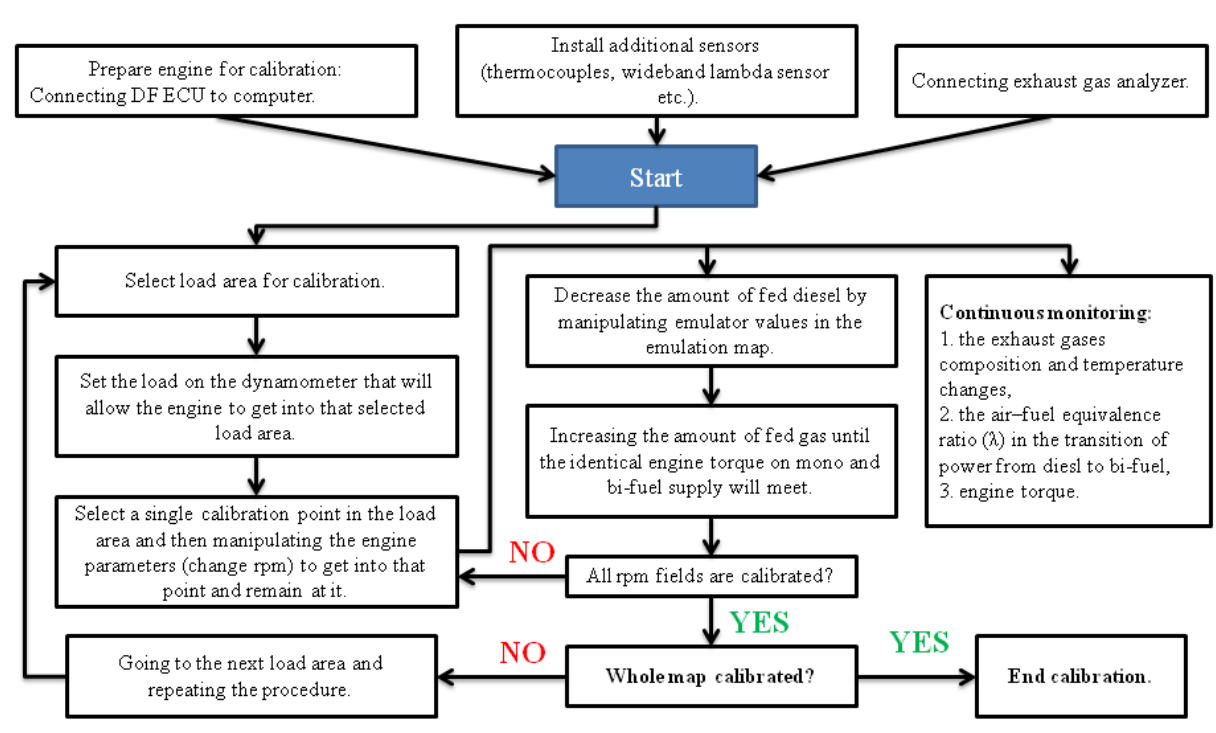
Fig. 7. DF ECU calibration